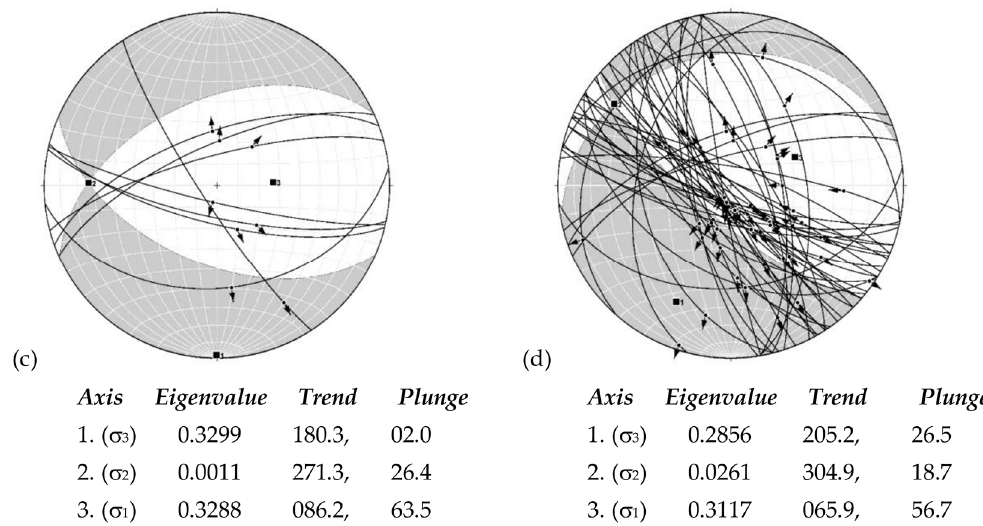
Figure 10. Orientation and paleo-stress analysis for D 7 fracture arrays measured in the Kukuluma and Matandani pits. For each area, the plot shows the fault planes as great circles and the lineations as arrows that point in the direction of movement of the hanging wall; these are placed on top of the fault plane solution (Bingham matrix solution) for the measured D 7 faults (compression dihedron in white; tension dihedron in grey). The Bingham solutions for each data set are shown below the stereoplots. ( a ) West wall of Matandani pit ( N = 30); ( b ) Northeast wall of Matandani pit ( N = 13); ( c ) East wall of Kukuluma pit ( N = 8); ( d ) All measurements from Kukuluma and Matandani pits combined ( N = 51). All plots show north-south to northeast-southwest extension with a steep σ 1 , and near horizontal σ 2 and σ 3 orientations.